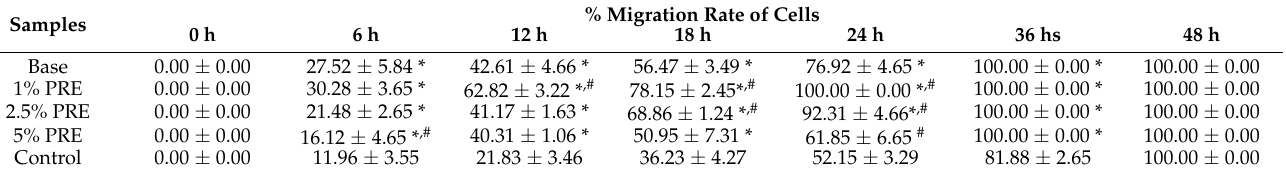
Table 9. Effect of the microemulsion base and microemulsions containing PRE at various concentra- tions on HGF cell